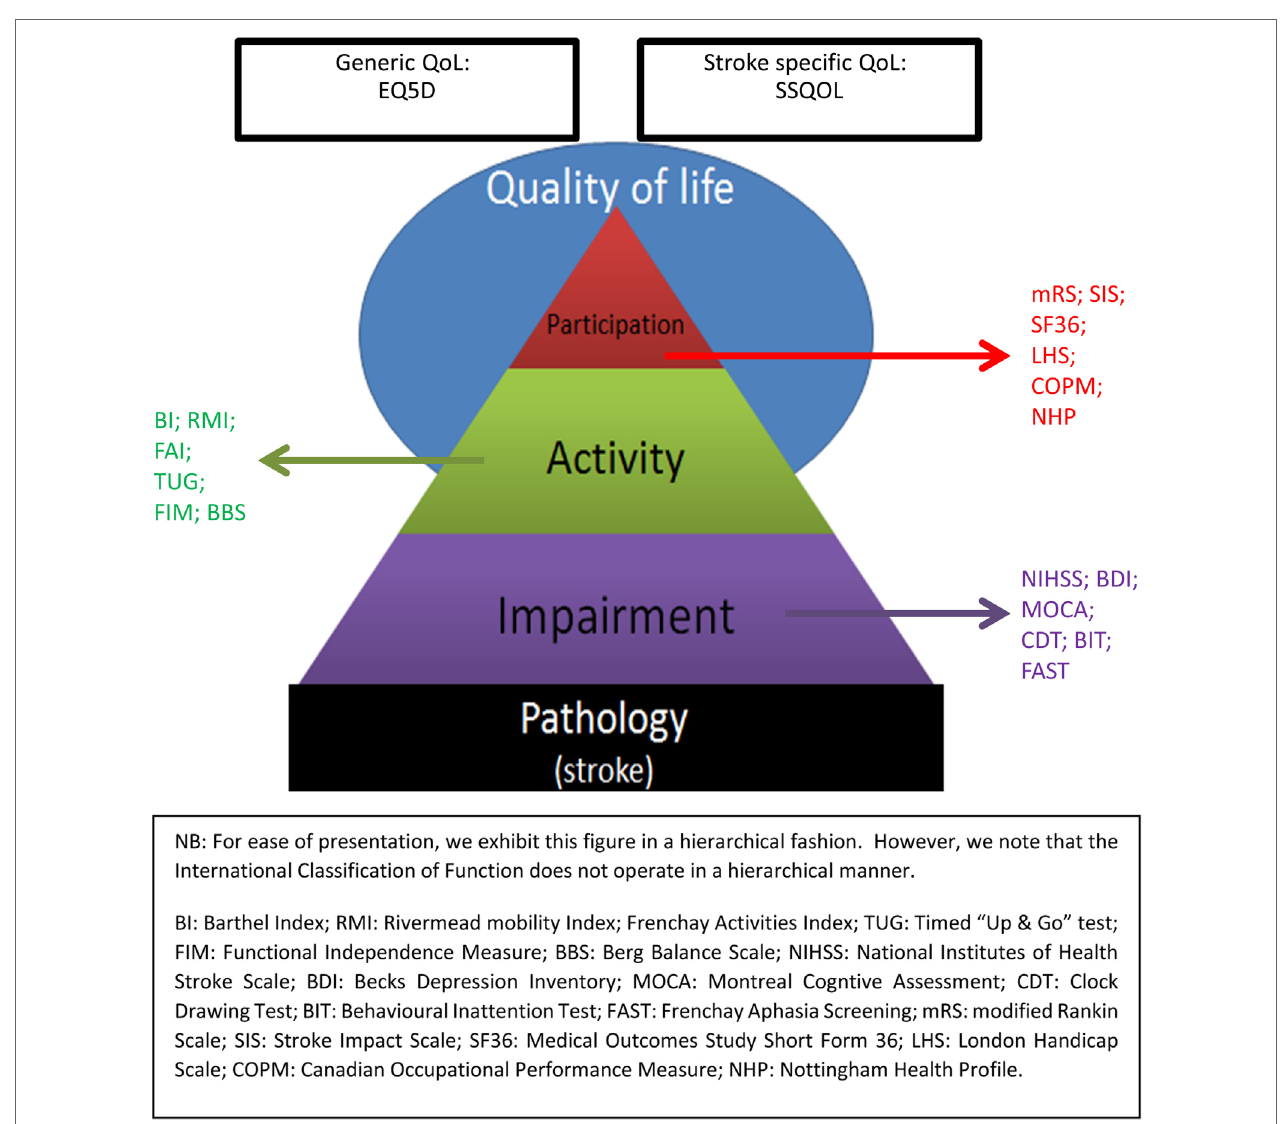
FiGURe 1 | World Health Organization International Classification of Function (WHO-ICF) Assessment